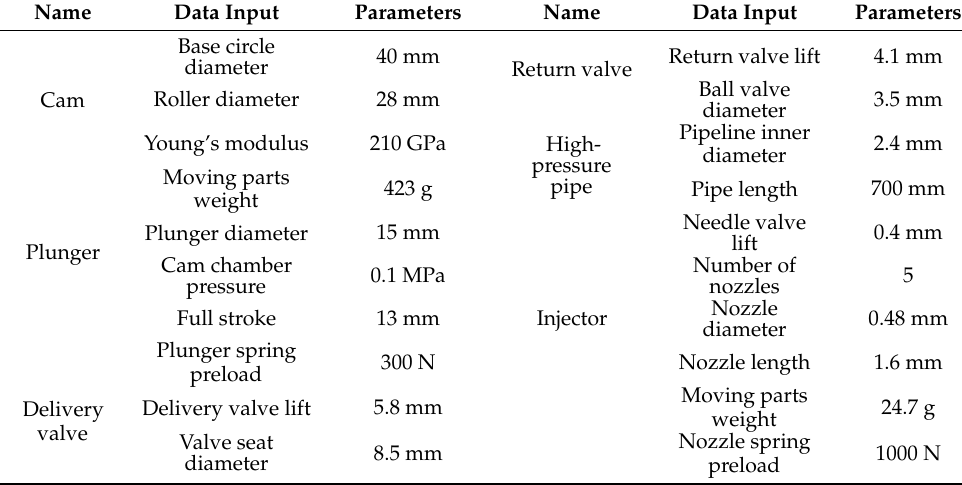
Table 3. The main configurations of injection system